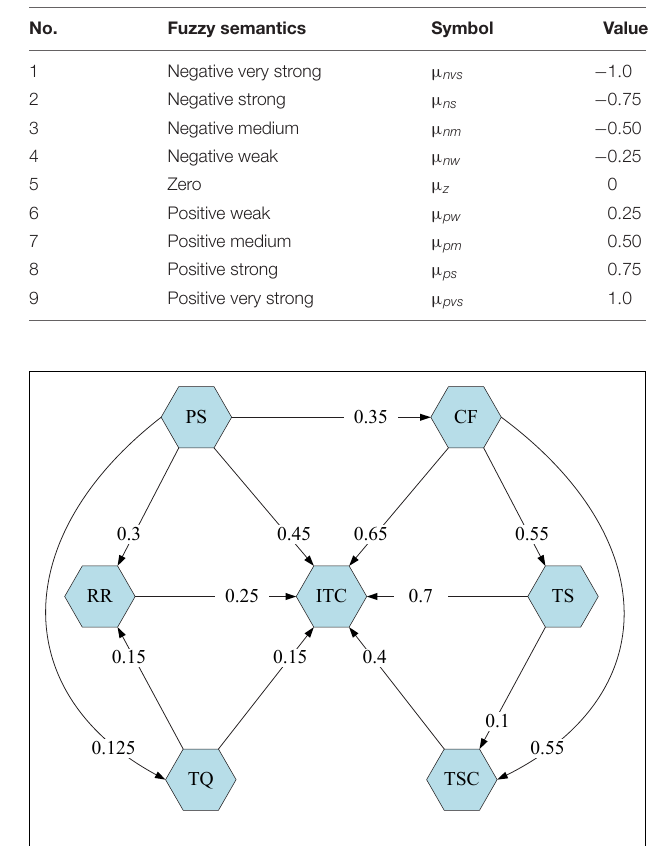
TABLE 3 | Results of exploratory factor analysis. TABLE 4 | The sources of the variables.